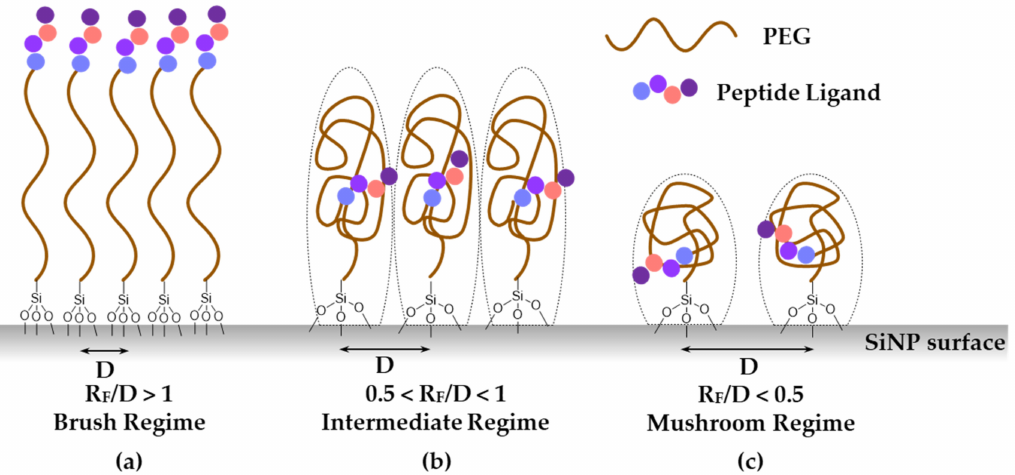
Figure 4. Schematic PEG–peptide behavior grafted on nanoparticle’s surface, depending on Flory’s radius R F and distance between two anchoring points, D. ( a ), ( b ), ( c ) presentation for brush, intermediate and mushroom regime